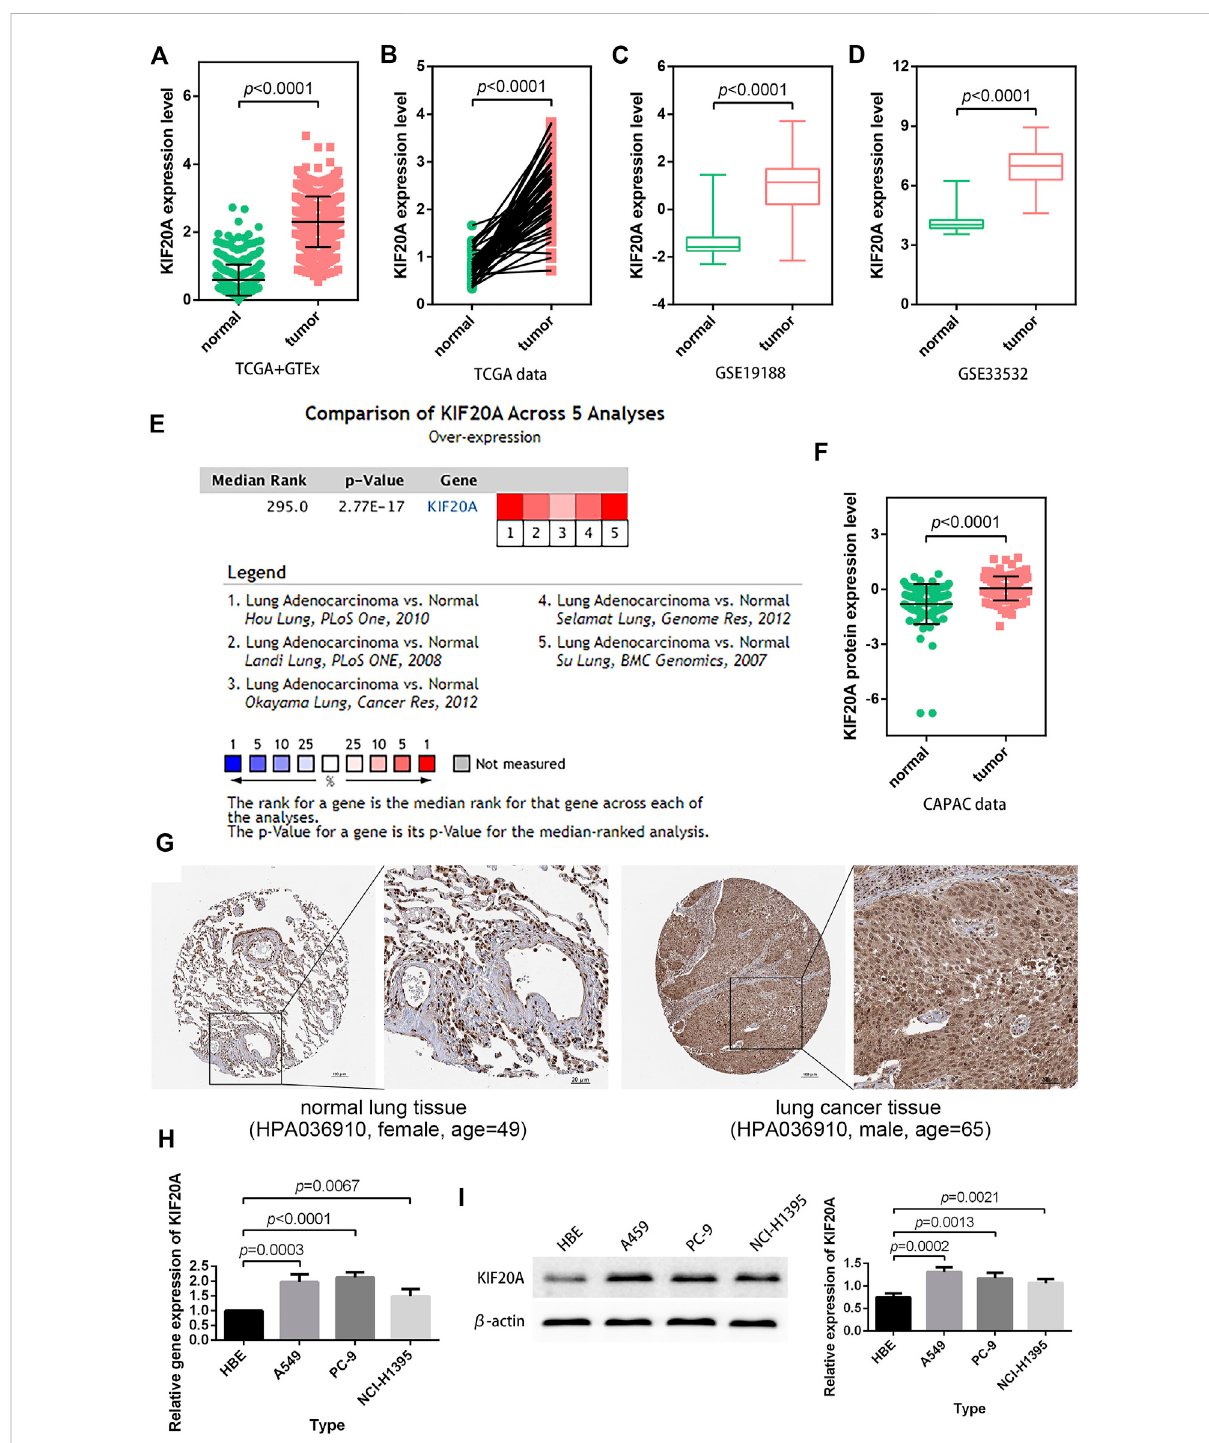
FIGURE 5 Veri fi cation of KIF20A expression. LUAD samples had higher KIF20A expression in both unpaired (A) and paired (B) differential analyses, and the observations were veri fi ed using GSE19188 (C) and GSE33532 (D) pro fi les. Meta-analysis (E) , protein differential analysis (F) , and immunohistochemical images (G) validatedthe overexpression of the KIF20A gene in LUAD. Quantitative real-time PCR (qRT-PCR) (H) and Western blot analysis (I) illustrate the signi fi cant upregulation of KIF20A expression in A549, PC-9, and NCI-H1395 cells compared with HBE